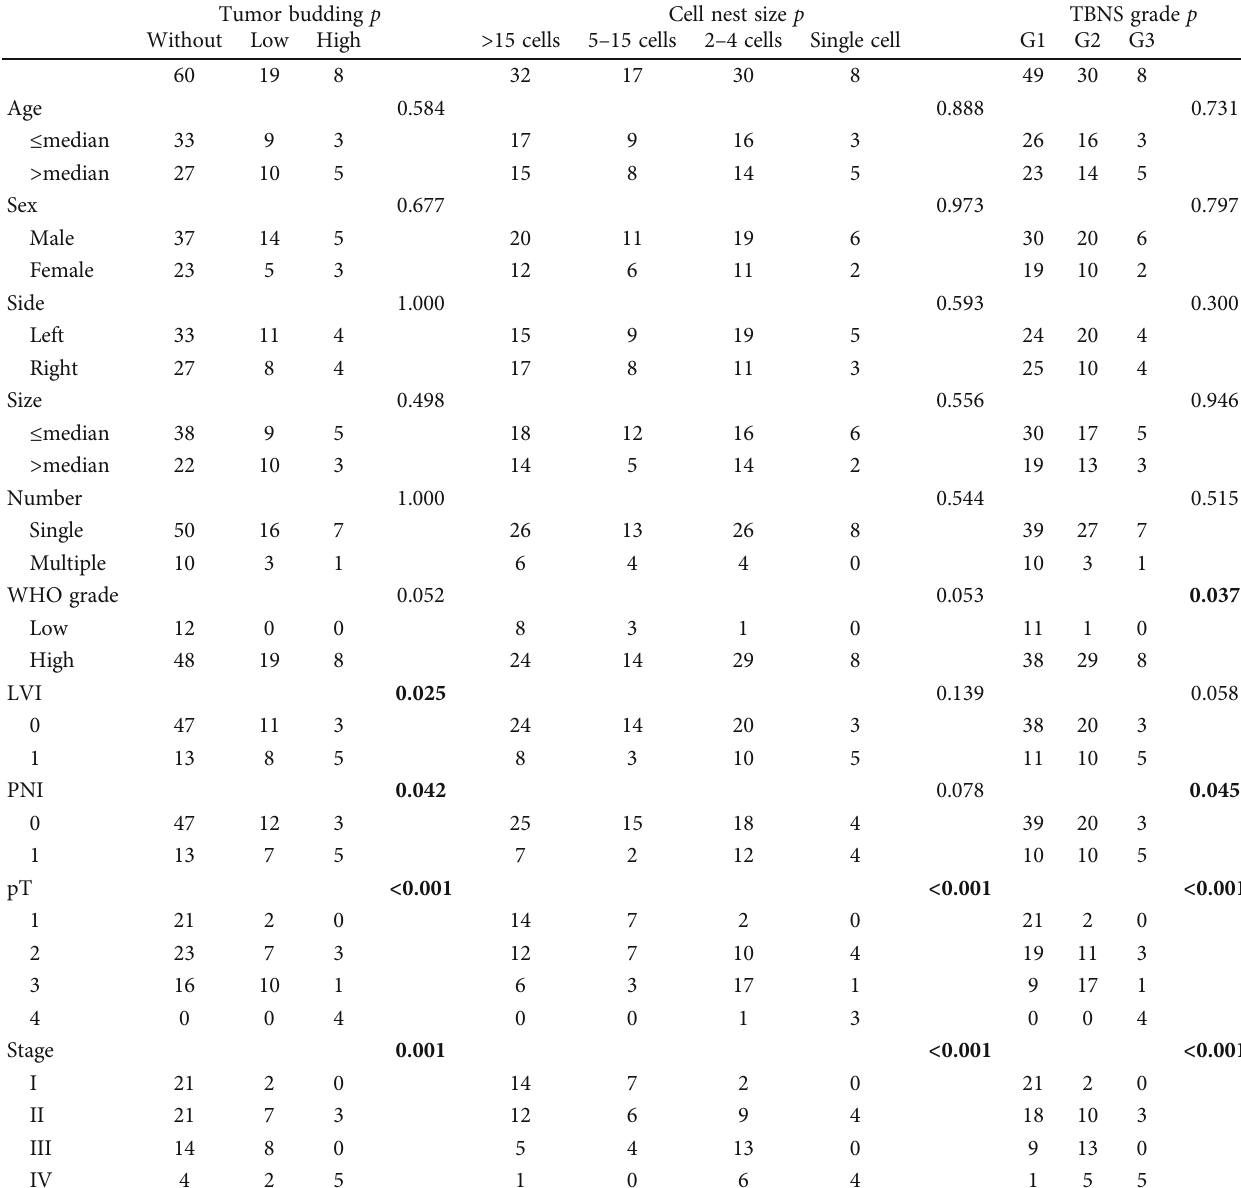
Table 1: Correlation of tumor budding, cell nest size, and TBNS system with clinicopathological parameters in ureter urothelial carcinoma. Tumor budding p Cell nest size